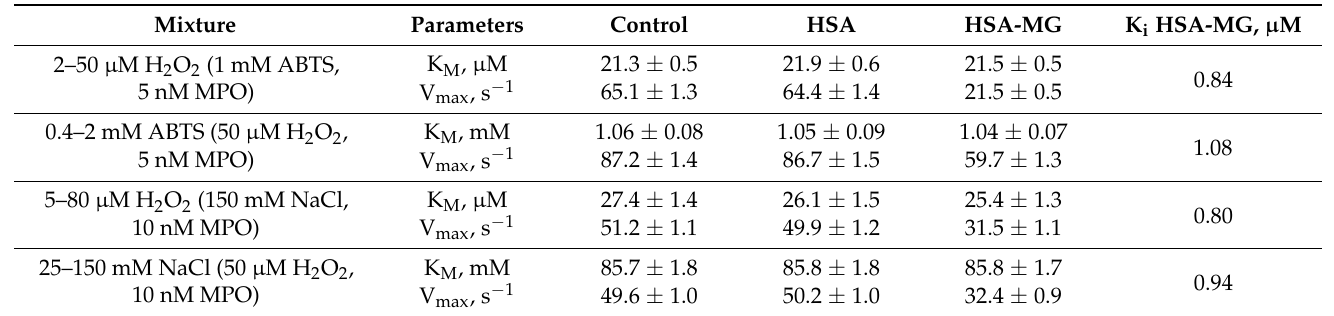
Table 1. Kinetic parameters of peroxidase and chlorinating activity of MPO in the presence of HSA and HSA-MG 1 .